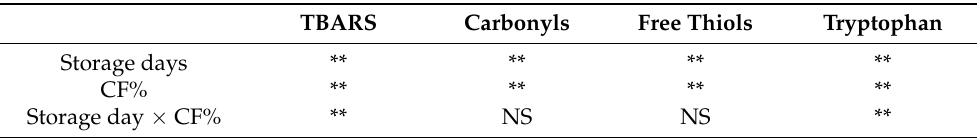
Table 4. Effect of storage days, CF%, and their interaction on TBARS, carbonyls, free thiol group, and